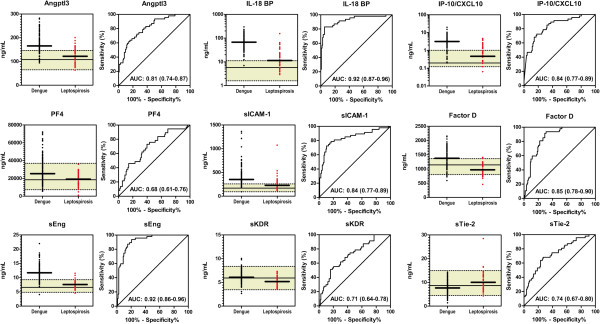
Biomarkers Discriminate Between Dengue Fever and Leptospirosis. Aligned dot plots and median of serum biomarker levels in dengue fever (n = 113) and leptospirosis (n = 47) measured at time of presentation during the acute phase of febrile illness. A population derived healthy range for adults in Bucaramanga, Colombia (n = 15) is represented by the shaded area with the median and 5-95% shown by the horizontal limits. All biomarkers were significantly different between cases with dengue fever and controls with leptospirosis (p < 0.001) following Bonferonni adjustment for multiple comparisons (19 pair-wise comparisons).